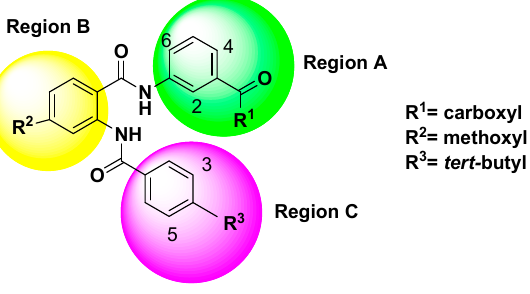
Figure 4. Structure of template compound (compound 30). The three regions A, B and C are depicted.